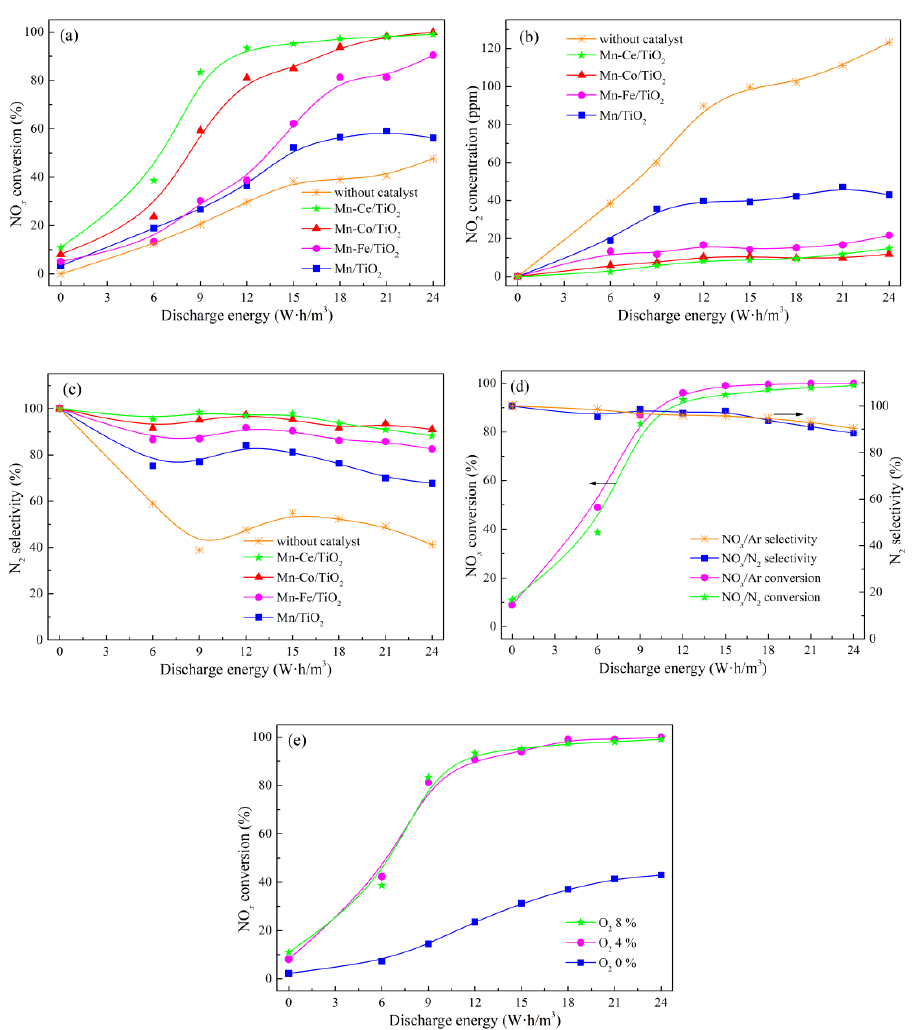
Figure 2. Catalytic performance of plasma-catalyst hybrid catalytic process at ambient temperature. 186 Gas mixture composition: 300 ppm NO, 300 ppm NH 3 , 8% O 2 , ~0.1 % H 2 O, and N 2 /Ar as balance gas. 187